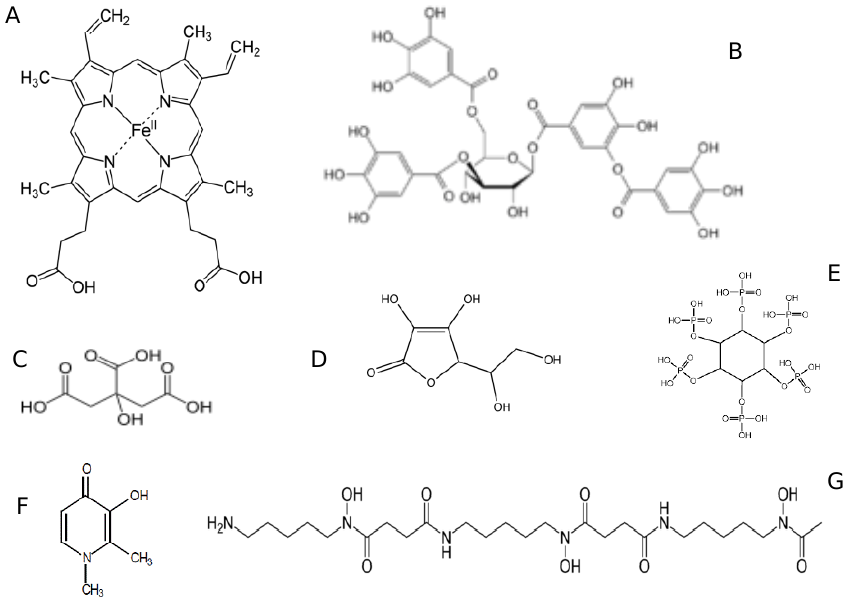
Figure 2. The chemical structure of molecules involved in iron absorption. Haem iron ( A ) is present in meat products and is better absorbed than non-haem iron. Tannic acid ( B ) and phytic acid ( E ) inhibit non-haem iron absorption. Citric acid ( C ) and ascorbic acid ( D ) facilitate non-haem iron absorption. The chelating drugs deferiprone ( F ) and deferoxamine ( G ) inhibit iron absorption.